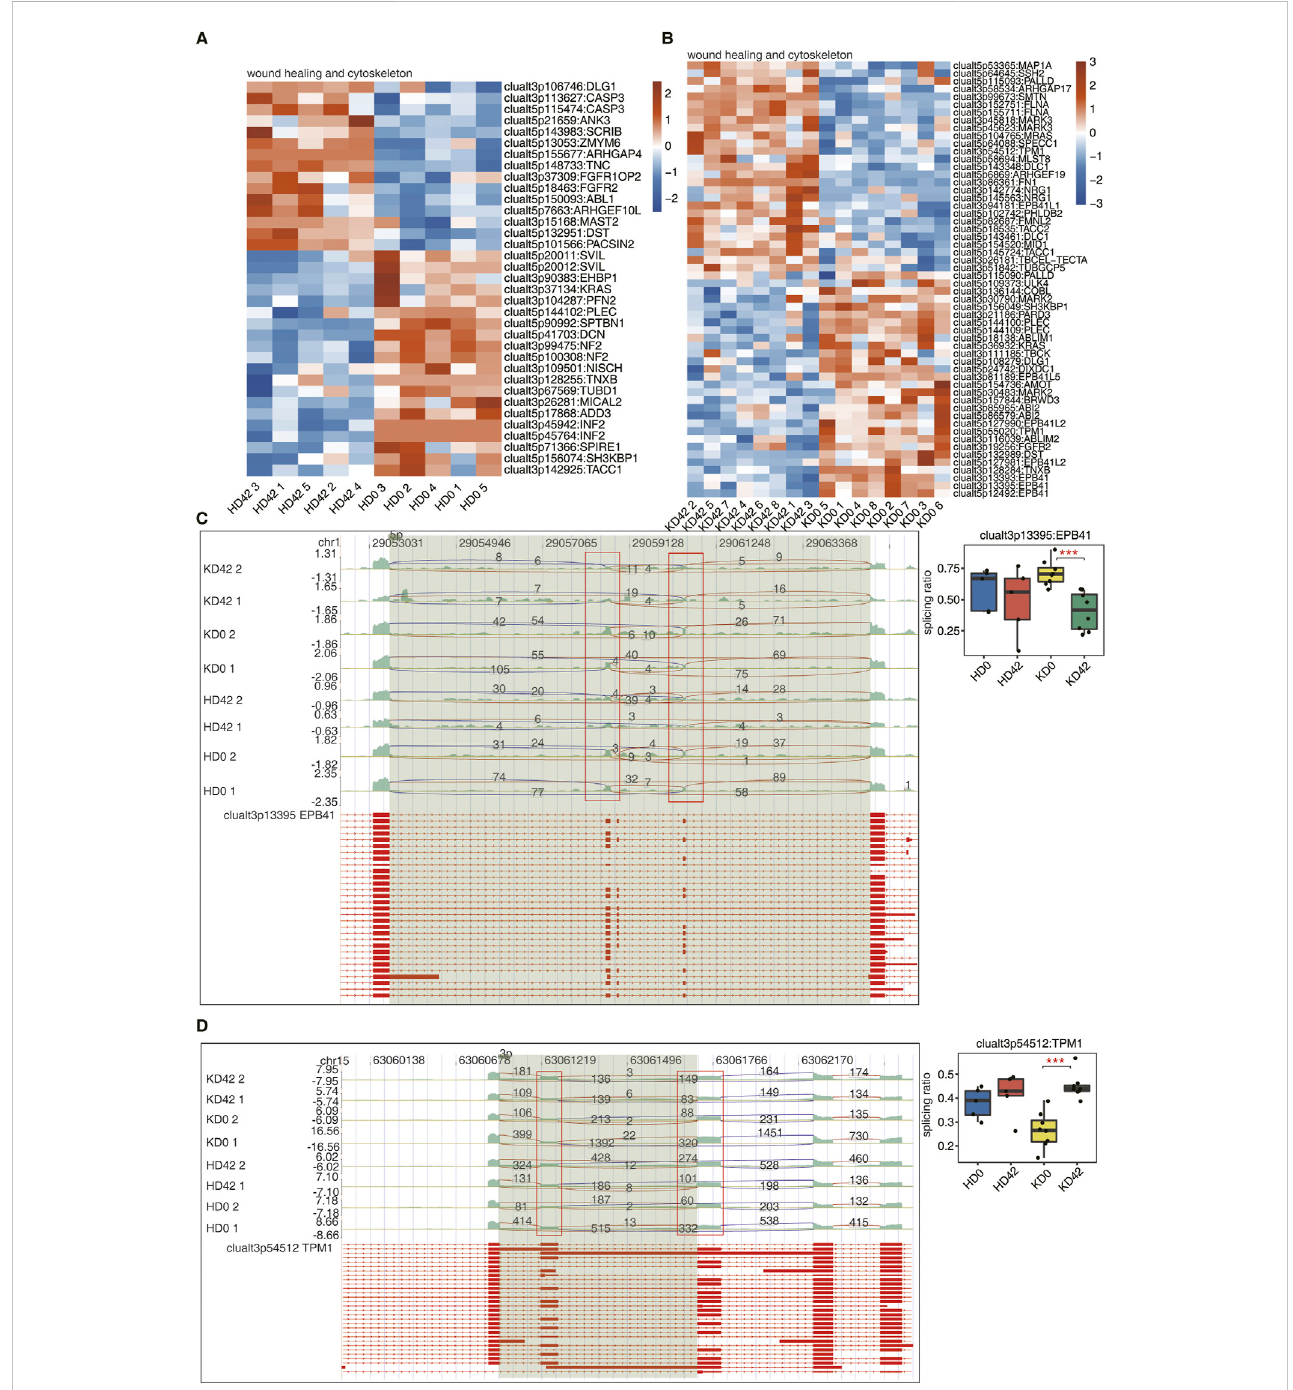
FIGURE 3 Analysis of differential AS of wound healing-associated genes in skin tissue from KPI and HC. (A, B) The Heatmap diagram shows the splicing ratio of wound healing and cytoskeleton in the KPI and HC. (C) Visualization of junction reads distribution of erythrocyte membrane protein band 4.1 (EBP41) in AS events clualt3p13395 from differentgroups.Splicejunctions werelabeledwithSJ readsthenumber, andthealteredexon wasmarked outwitharedbox.The splicing events model is shown in the top panel. Boxplot in the bottom panel showing the splicing ratio pro fi le of the splicing event from EBP41. Boxplot showing splicing ratio of clualt3p13395 EPB41 on the right. * p ≤ 0.05, ** p ≤ 0.01,*** p ≤ 0.001. (D) Visualization of junction reads distribution of encoding tropomyosin (TPM1) in AS events clualt3p54512 from different groups. Splice junctions were labeled with SJ reads the number, and the altered exon was marked out with a red box. The splicing events model is shown in the top panel. Boxplot in the bottom panel showing the splicing ratio pro fi le of the splicing event from EBP41. Boxplot showing splicing ratio of clualt3p54512 TPM1 on the right. * p ≤ 0.05, ** p ≤ 0.01,*** p ≤